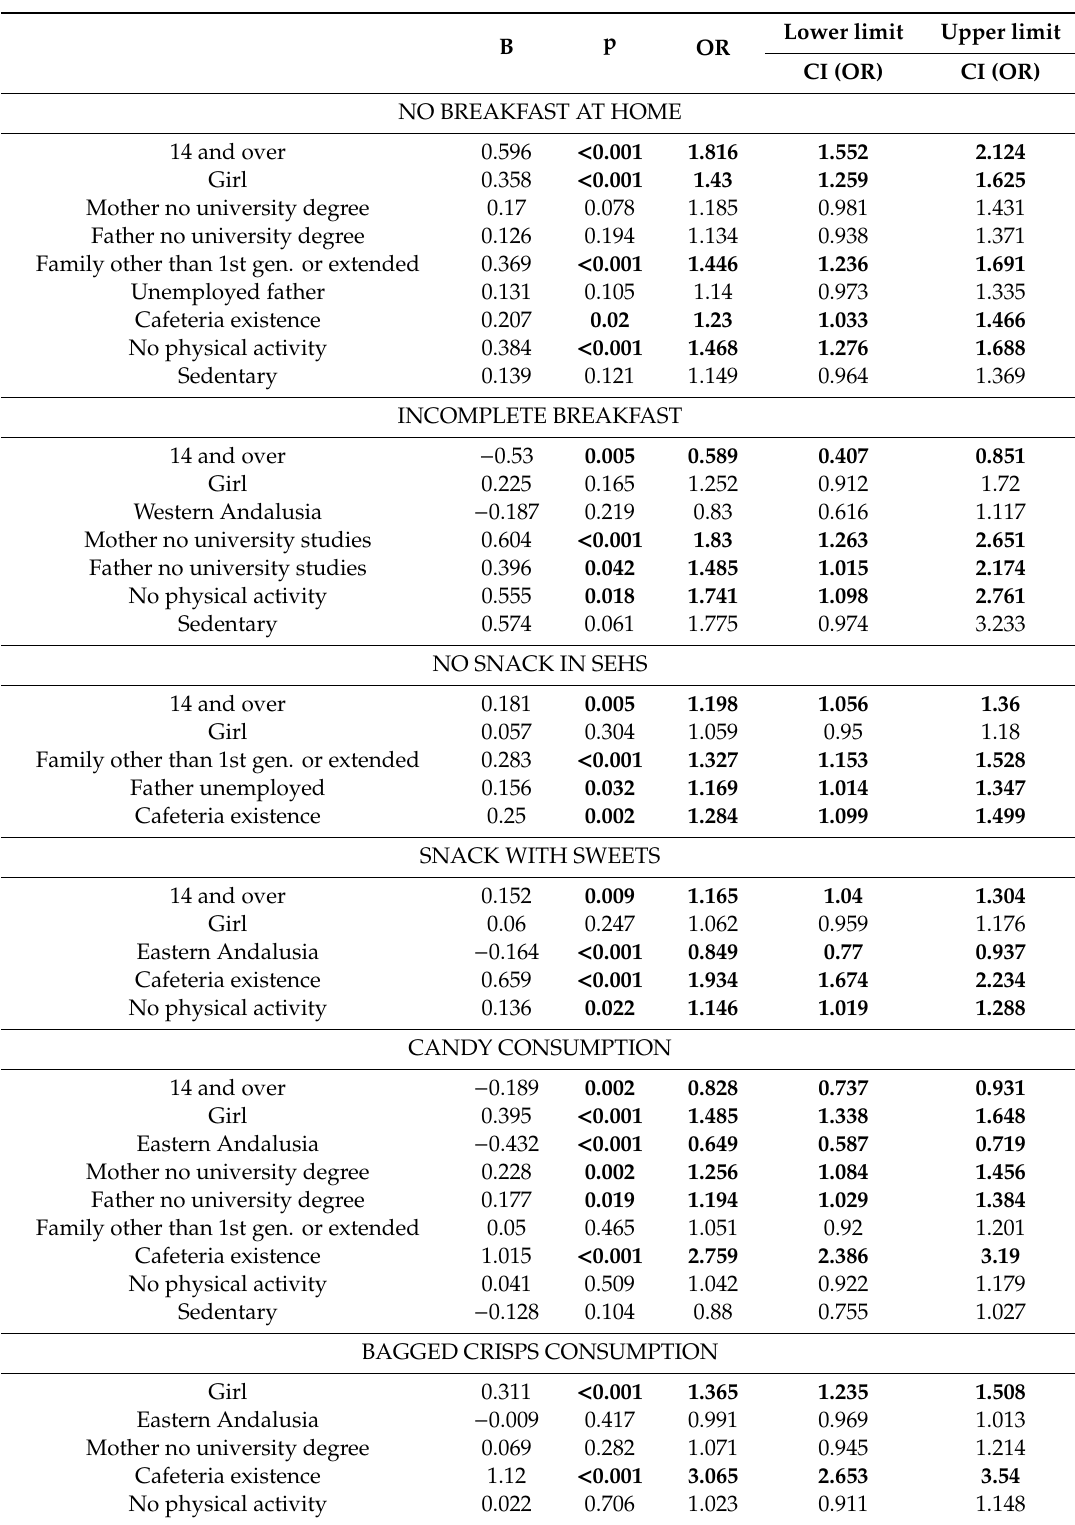
Table 6. Multivariate regression analysis. Factors associated with unhealthy eating habits during the school